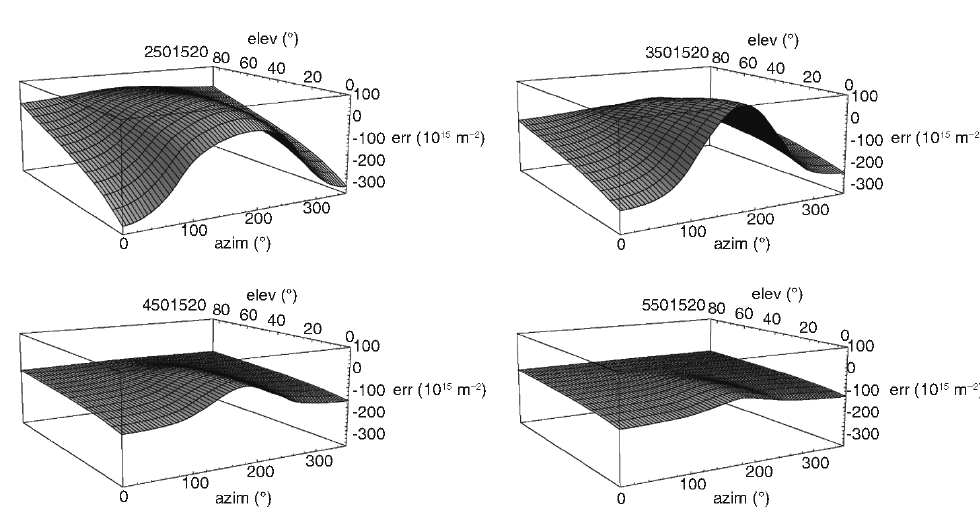
Fig. 18.2. Pierce point approach: error dependence on satellite elevation and azimuth measured with respect to pierce point. Pierce point latitude 25°N, 35°N, 45°N, 55°N respectively, for 15°E and 20:00